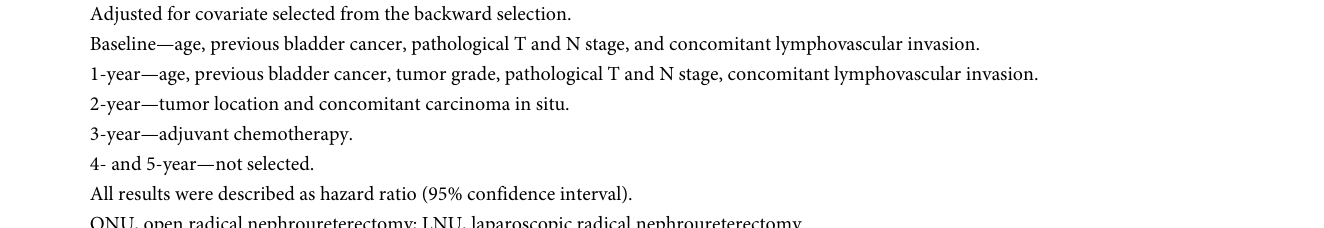
Surgical type (LNU vs.